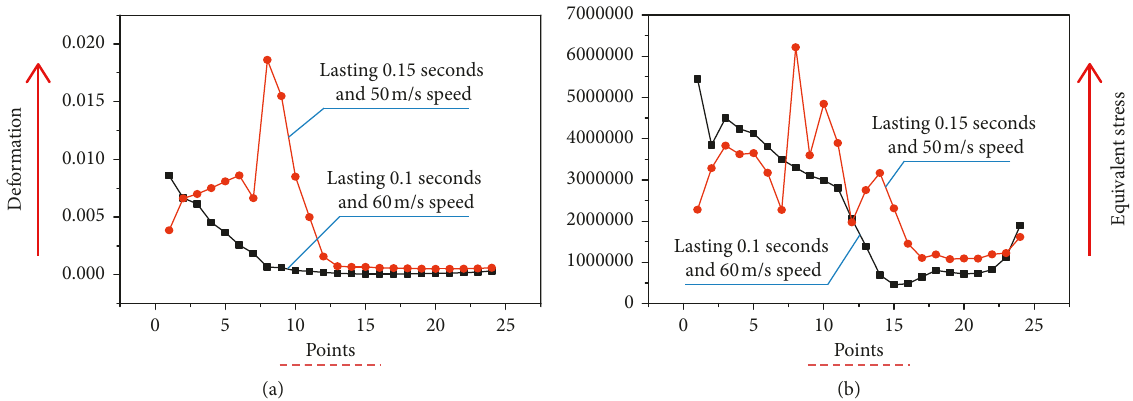
Figure 14: Deformation (a) and equivalent stress (b) of the monitoring points. Black curve stands for scheme 1, and red curve represents scheme 2.